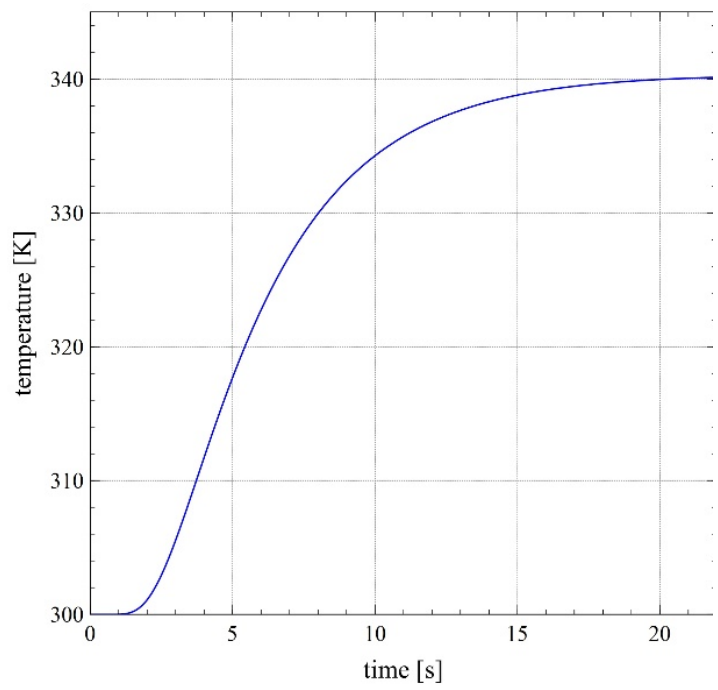
Figure 18. Time courses of the temperature at the external barrel surface at the validation cross- section.